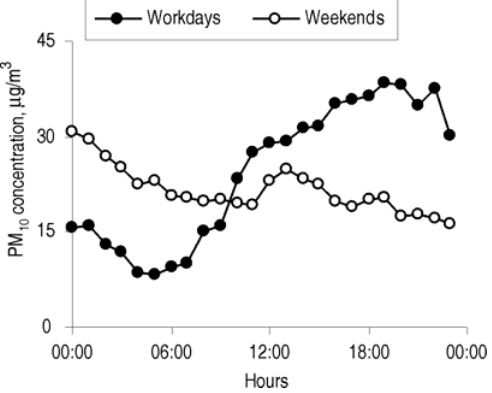
Fig 2 . Daily variations of PM 10 mass concentrations du- ring workdays and weekends